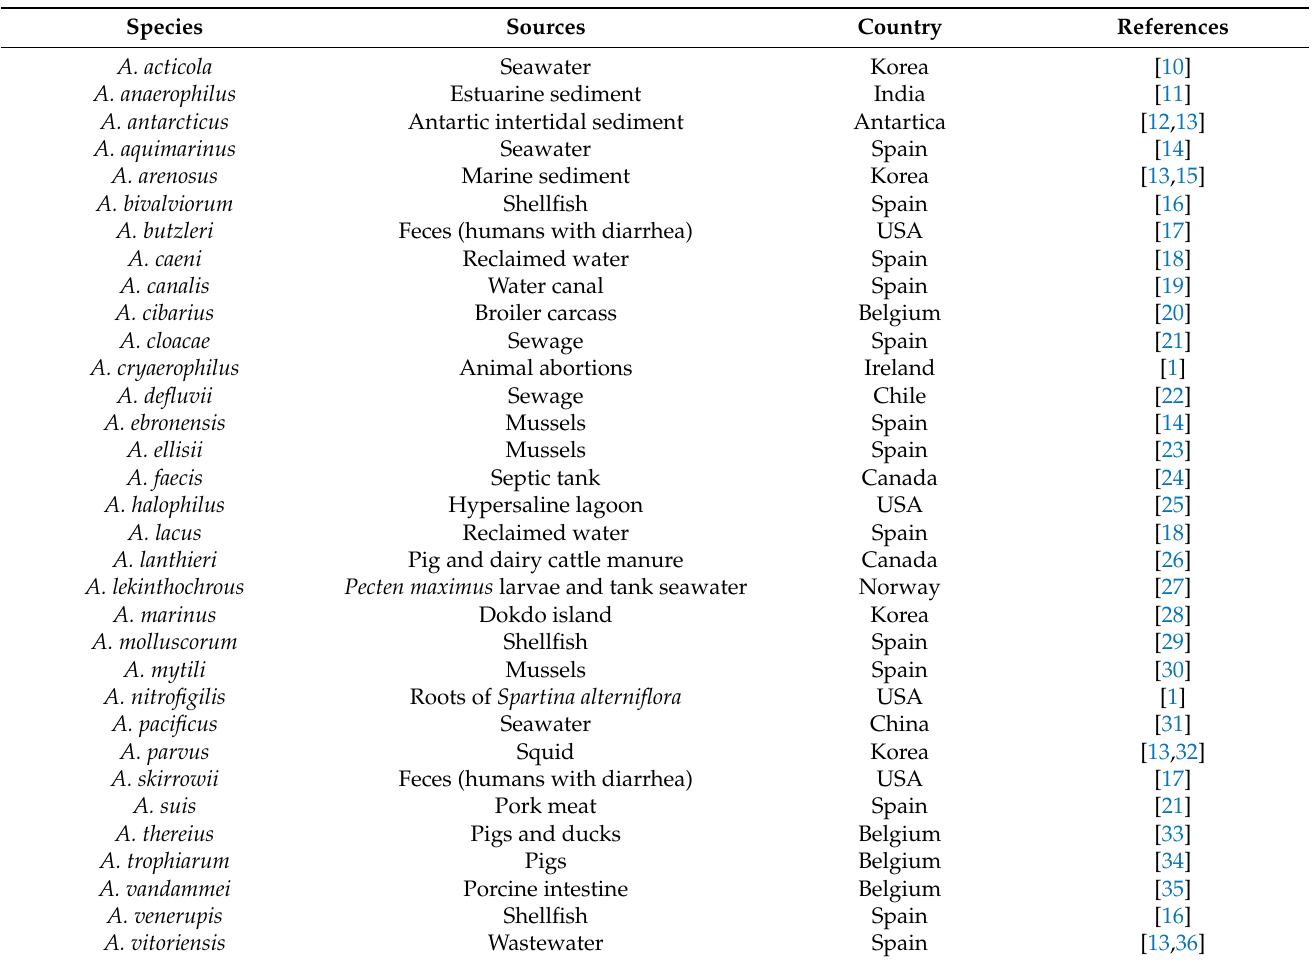
Table 1. List of Arcobacter species with their sources and countries of